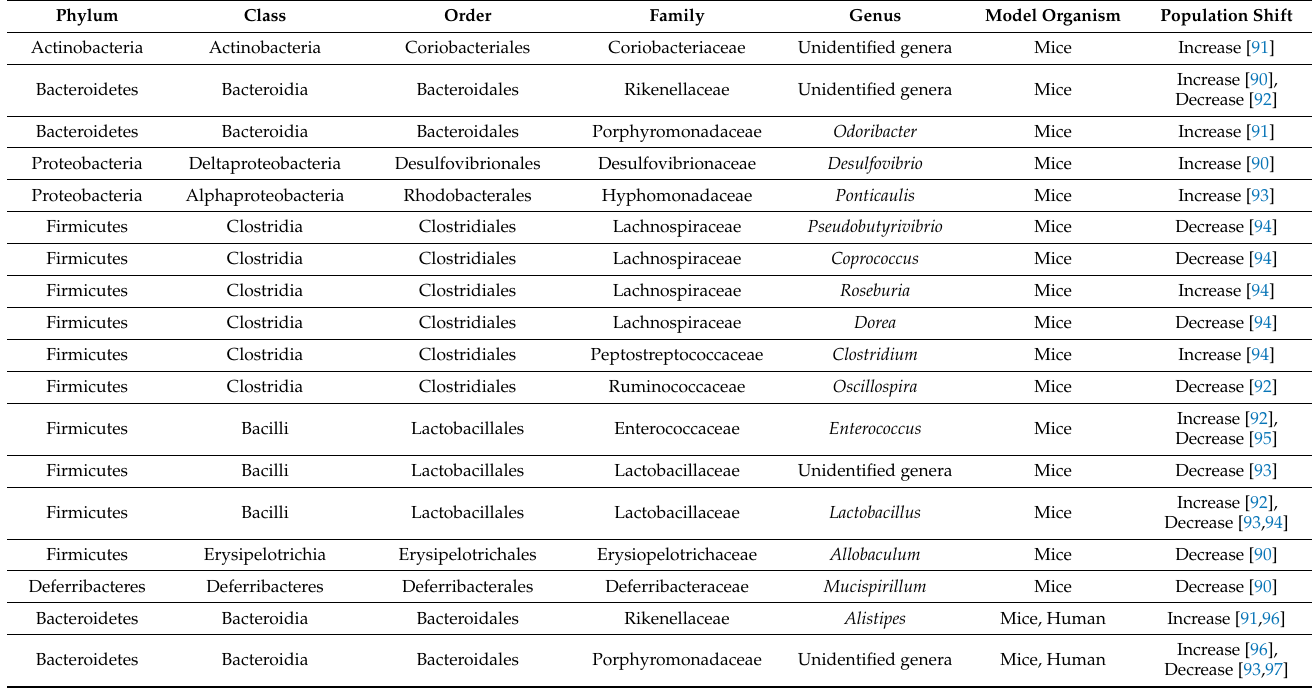
Table 2. Alterations in the intestinal microbial diversity observed in patients with depression and animals exposed to